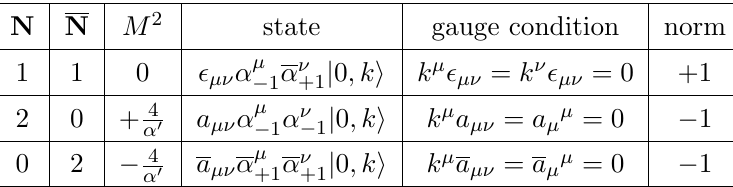
Table 2 . Spectrum satisfying the harmonic Virasoro conditions. Their norms are tabulated in the last